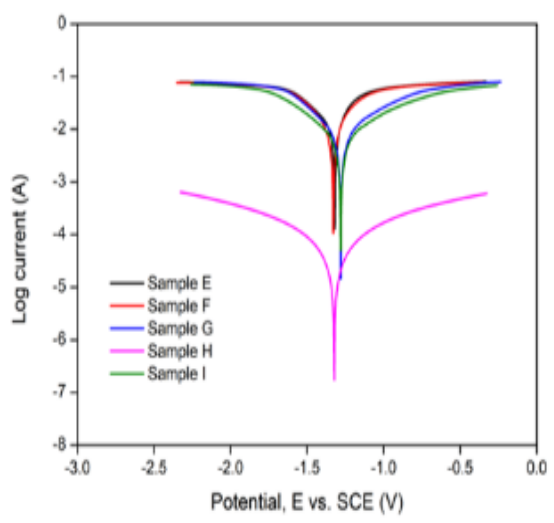
Figure 20. Tafel plots of samples E – I.